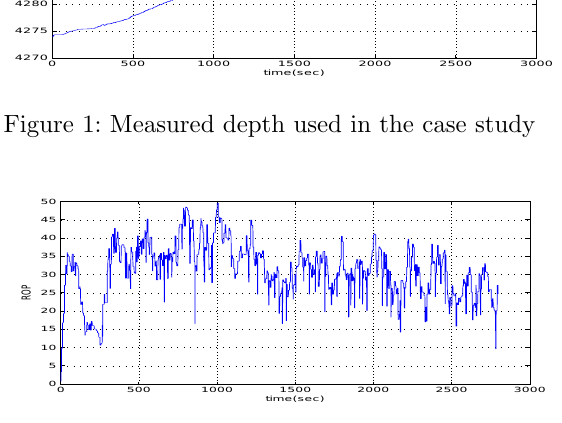
Figure 2: Instantaneous ROP calculated in the case study